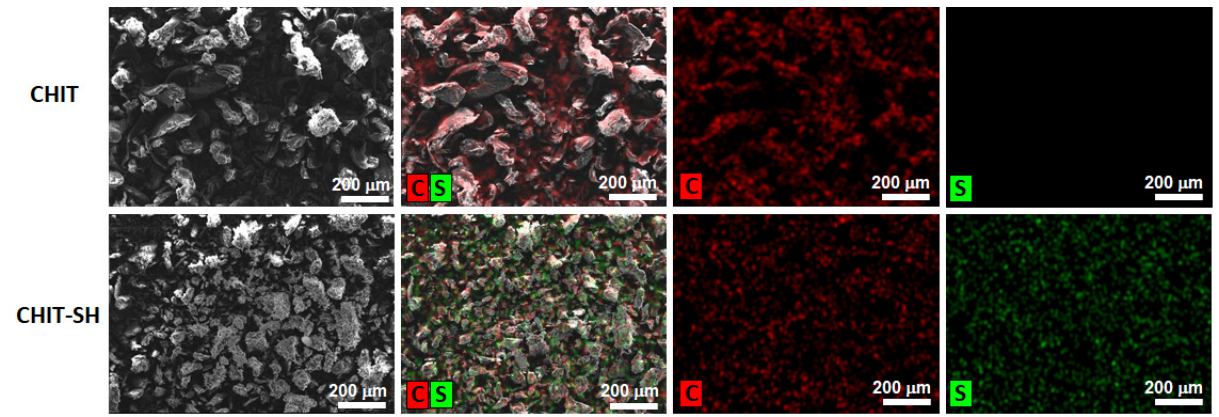
Figure 6. EDX measurements of CHIT and CHIT-SH, C and S are the carbon and sulfur elements,